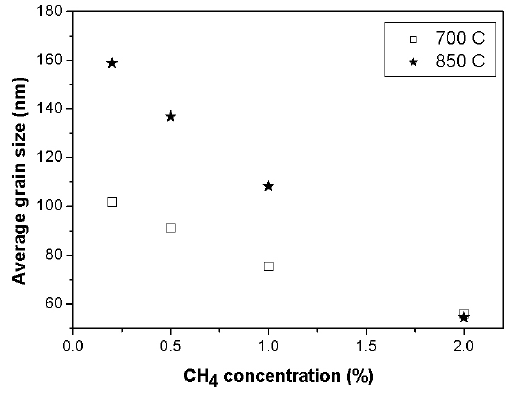
Figure 2: Average grain size of the NCD films prepared under different